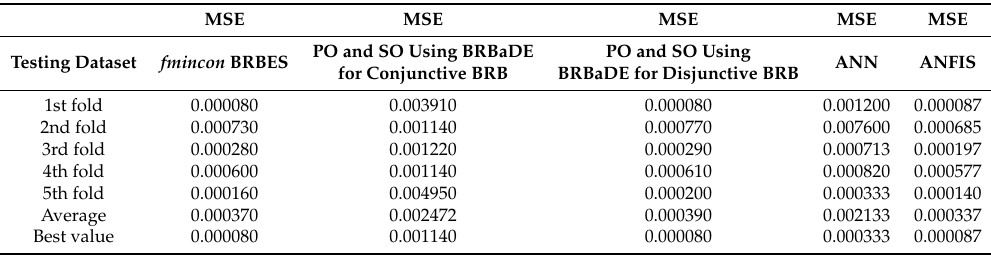
Table 6. MSE for different kinds of BRBES using PO and SO using BRBaDE, ANFIS, ANN, and the fmincon of testing datasets from Facebook. MSE MSE